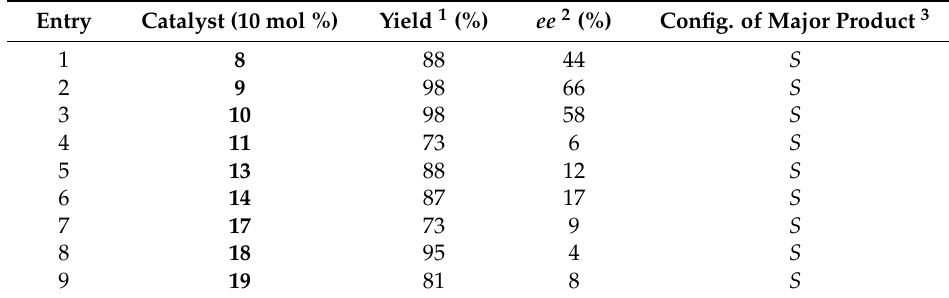
Table 1. Addition of diethylzinc to benzaldehyde, catalyzed by various types of diol, triols, and aminodiols at room